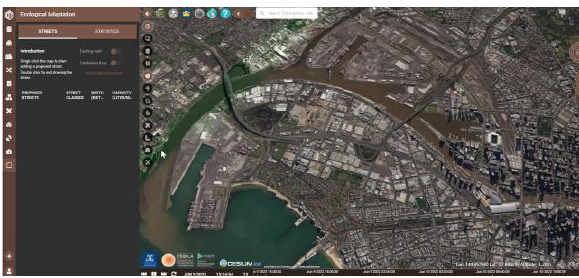
Figure 8: The user interface and flood infrastructure analytic tool prototype. Image credit Yibo